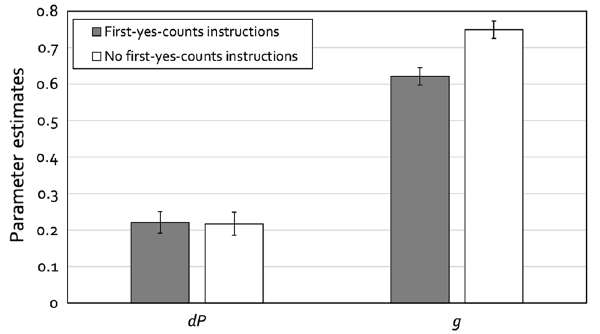
Figure 3. Estimates of parameters dP (detection of the presence of the culprit) and g (guessing-based selection) of the 2-HT eyewitness identification model as a function of lineup instructions (first-yes-counts instructions vs. no first-yes-counts instructions) for the conceptual replication of the sequential-lineup conditions of Horry et al. 32 . The error bars represent the standard